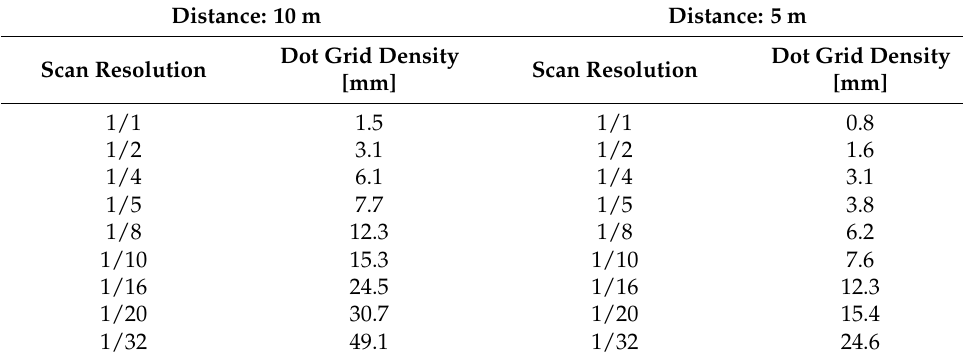
Table 1. Examples of FARO Focus S70 scanner operation